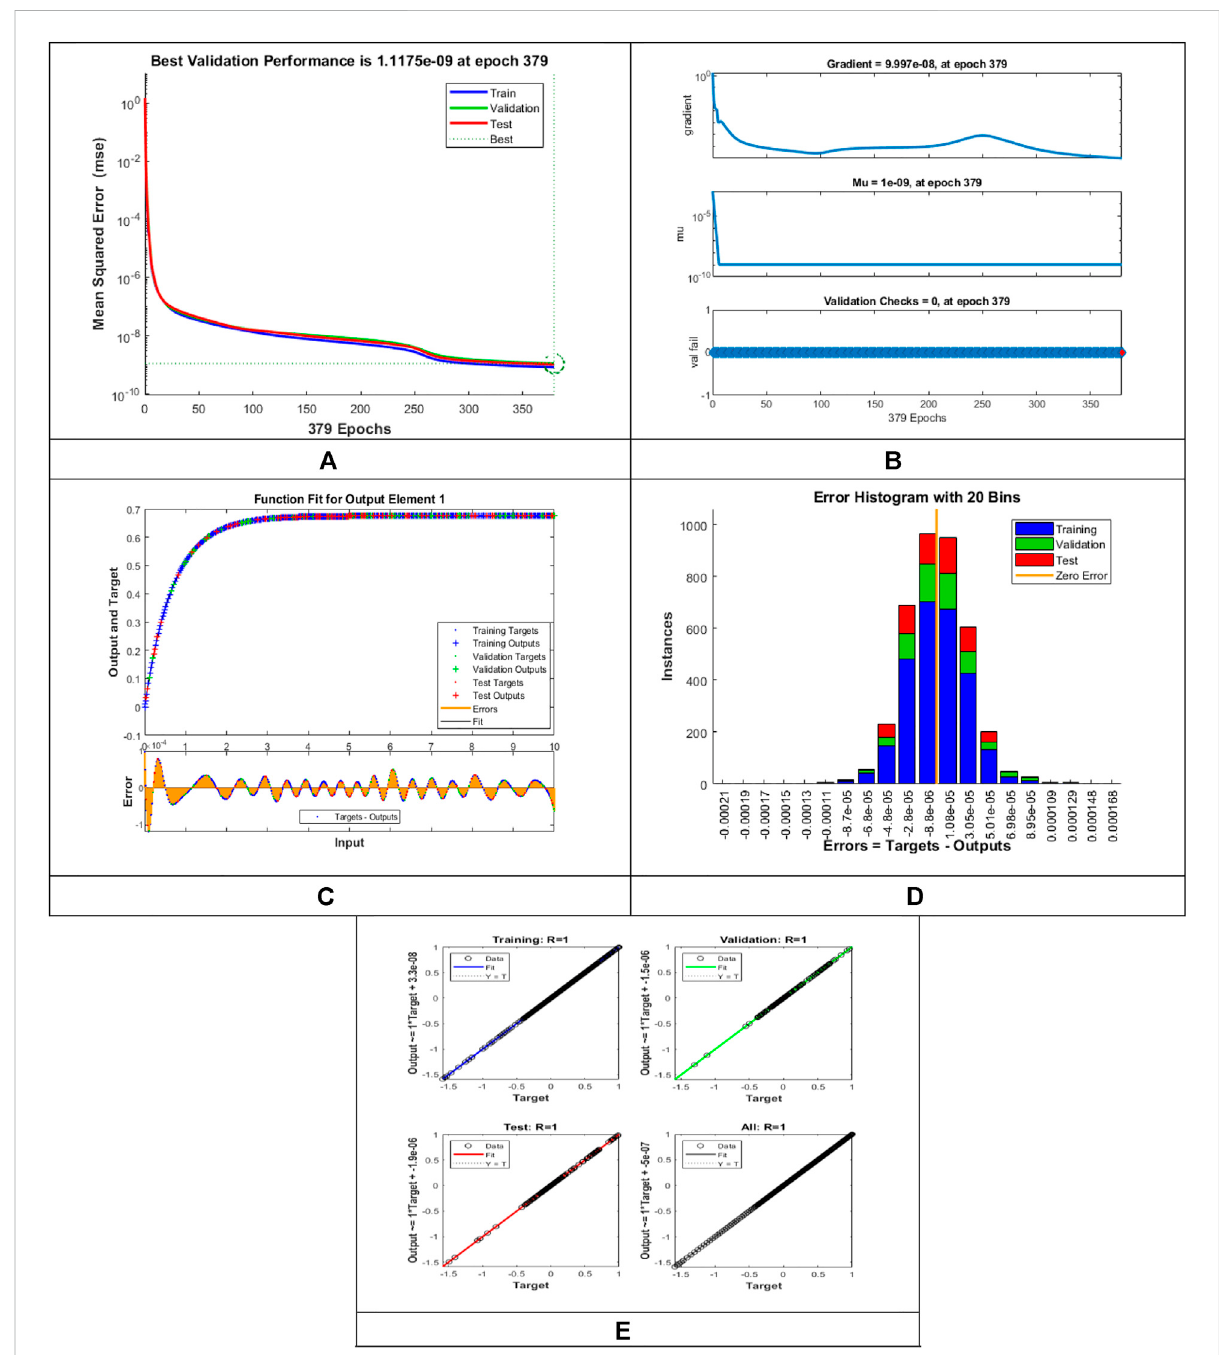
FIGURE 8 PictorialillustrationfortheLMLA-BPNNbaseonvariantsof S vs θ ( η ) forMHD-WNF-HGA. (A) M-S-Edemonstration, (B) transitionstateanalysis, (C) curve fi tting, (D) error histogram, and (E) regression